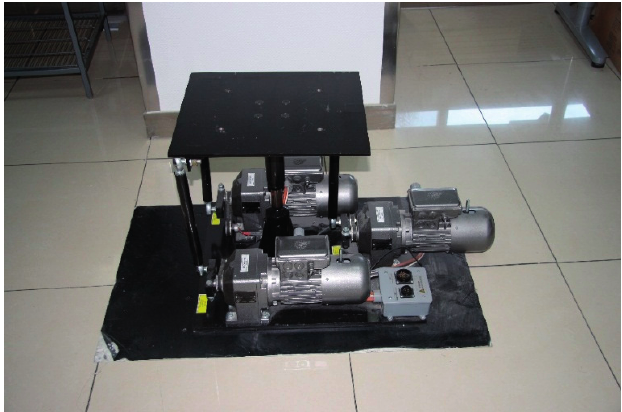
Figure 1. The three axis motion